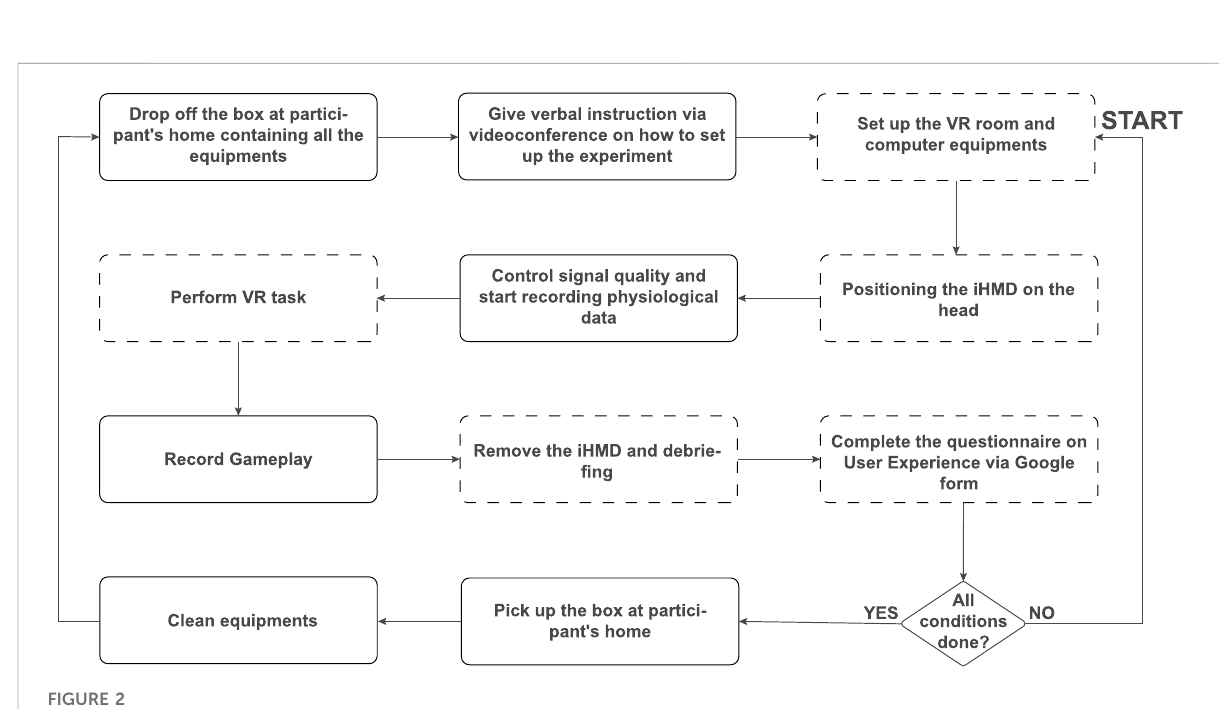
FIGURE 2 Flowchart of the experimental procedure. The solid rectangles correspond to the experimenter tasks and the dashed rectangles to participant